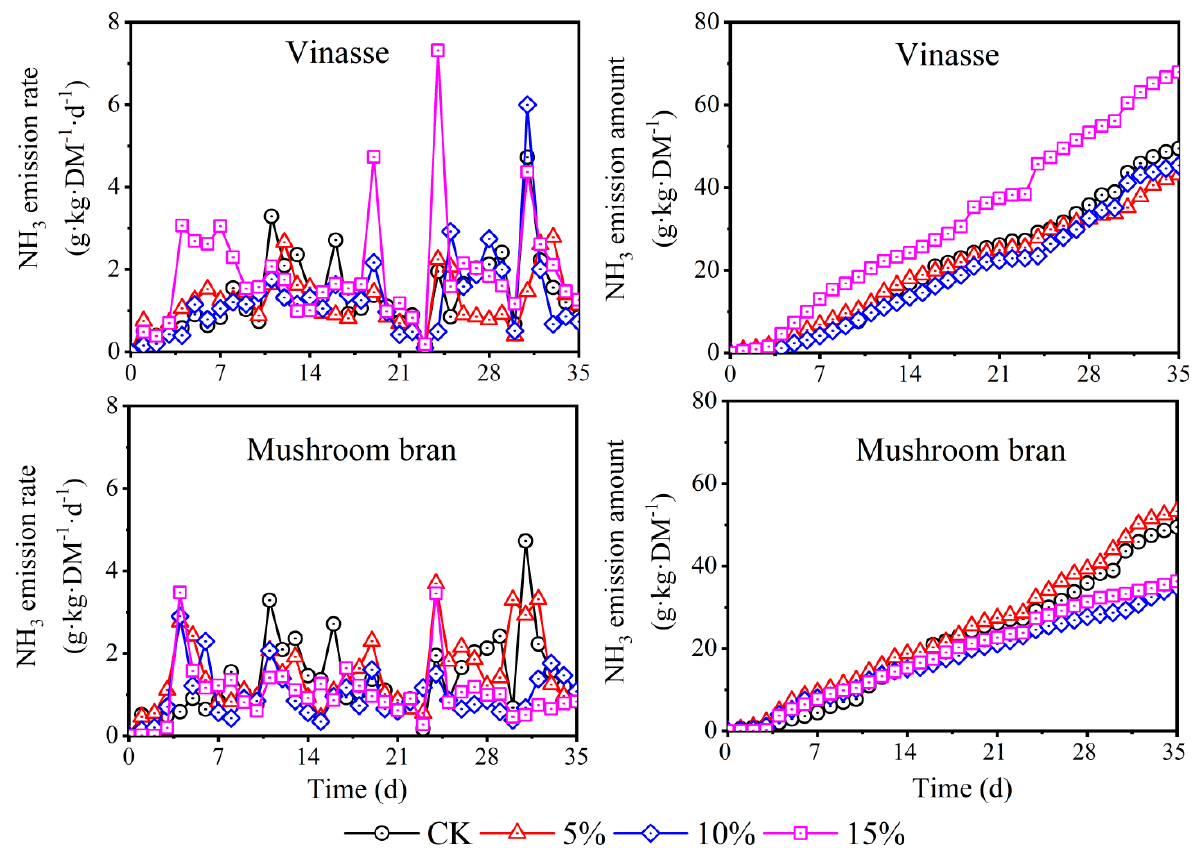
Figure 6. Variation of NH 3 emission during composting